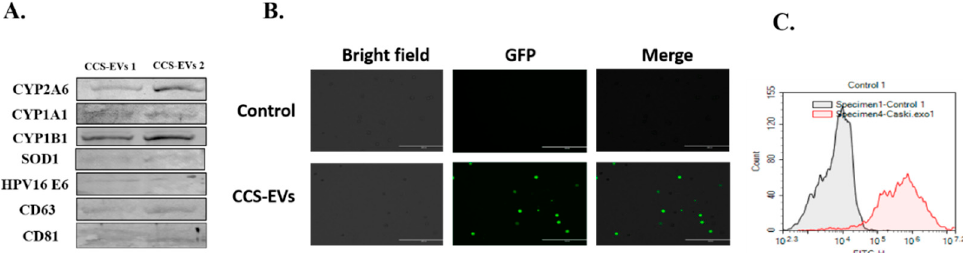
Figure 5. Differentiated U1 cell line uptake CCS-derived EVs (CCS-EVs) that contain oxidative stress factors. ( A ) The proteins obtained from CCS-derived EVs (CCS-EVs) were examined for the expression of EVs markers, CD63 and CD81, CYPs (1A1, 1B1, 2A6) and AOEs (SOD1, SOD2, and catalase) and HPV 16 oncoproteins (E6 and E7). ( B ) To monitor the EVs uptake by U1 cells, we labeled the CCS-EVs with GFP (Green Fluorescent Protein) and treated the labeled EVs to U1 cells. After 6 h of incubation, we monitored the fluorescent intensity of GFP under fluorescent microscope. ( C ) The GFP fluorescence was further quantified using flow cytometry.